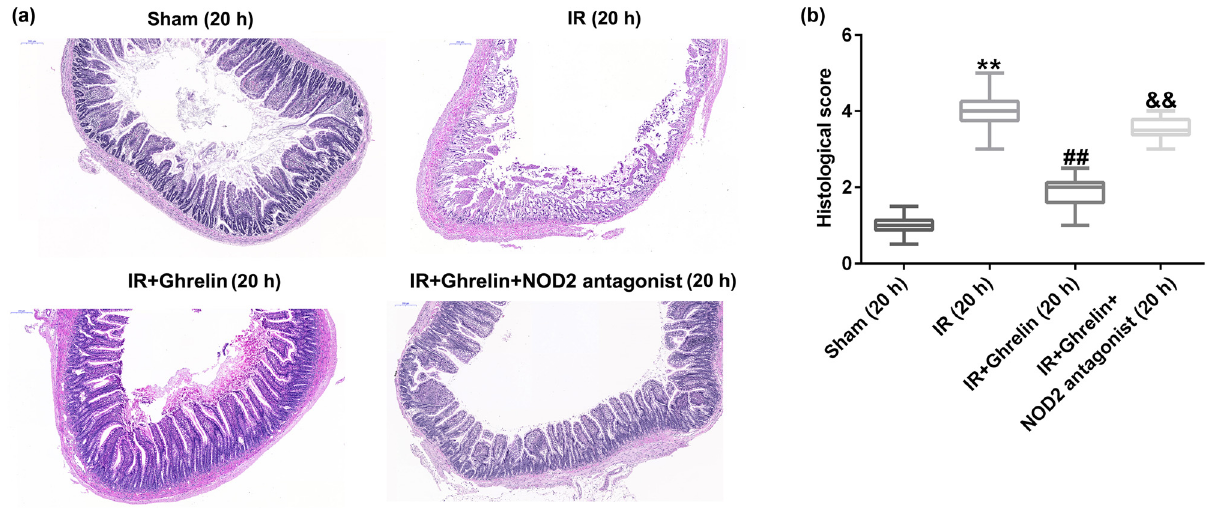
Figure 1: NOD2 antagonist reversed the e ff ects of ghrelin on small bowel tissue injury. Rats were euthanized at either 4 or 20 h after treatment, and their small intestine tissue samples were obtained. ( a ) Representative intestinal sections from rats of di ff erent groups were stained with hematoxylin and eosin. The epithelial structure was clearly demarcated in the sham group. More serious mucosal damage was found in the I/R group than in the sham group. Ghrelin relieved mucosal injury compared to the I/R group. The NOD2 antagonist aggravated mucosal injury in the I/R group. ( b ) The histological score was determined. Data were expressed as mean ± SD, n = 6; ** P < 0.01 vs sham; ## P < 0.01 vs IR; and P < 0.01 vs IR +